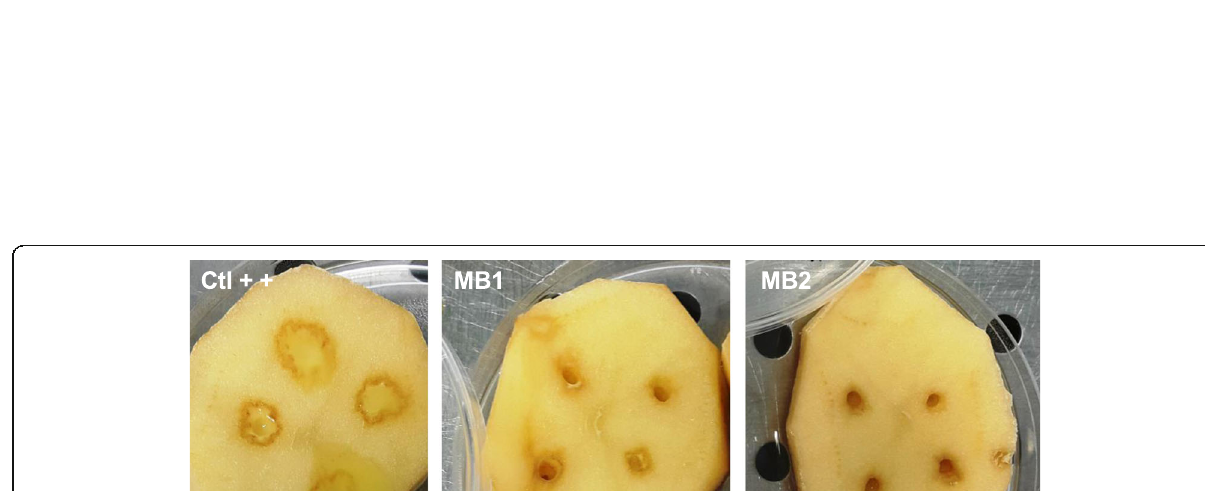
Fig. 5 Effect of bacterial antagonists against Erwinia amylovora infection on detached immature pear fruits (after 4 days ( A ) and after 9 days ( B )) (means ± SD). Levels not connected by same letter are significantly (p < 0.05) different according to Chi-square ’ s test